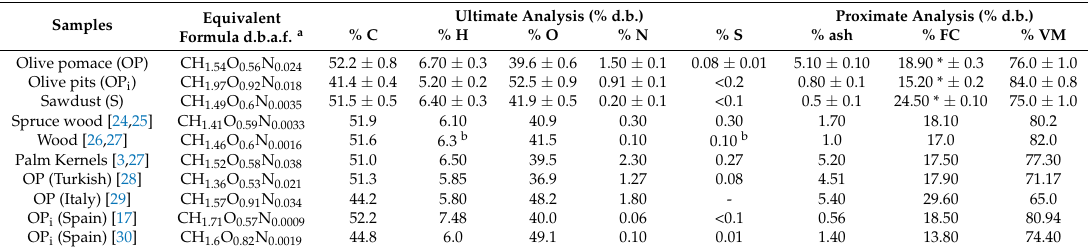
Table 2. Raw materials characteristics.